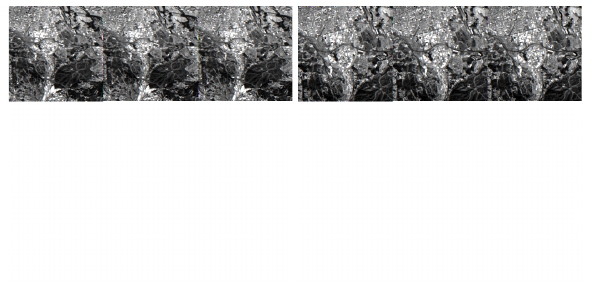
Figure 4. Worldview-1 Stereo images for Terrassa